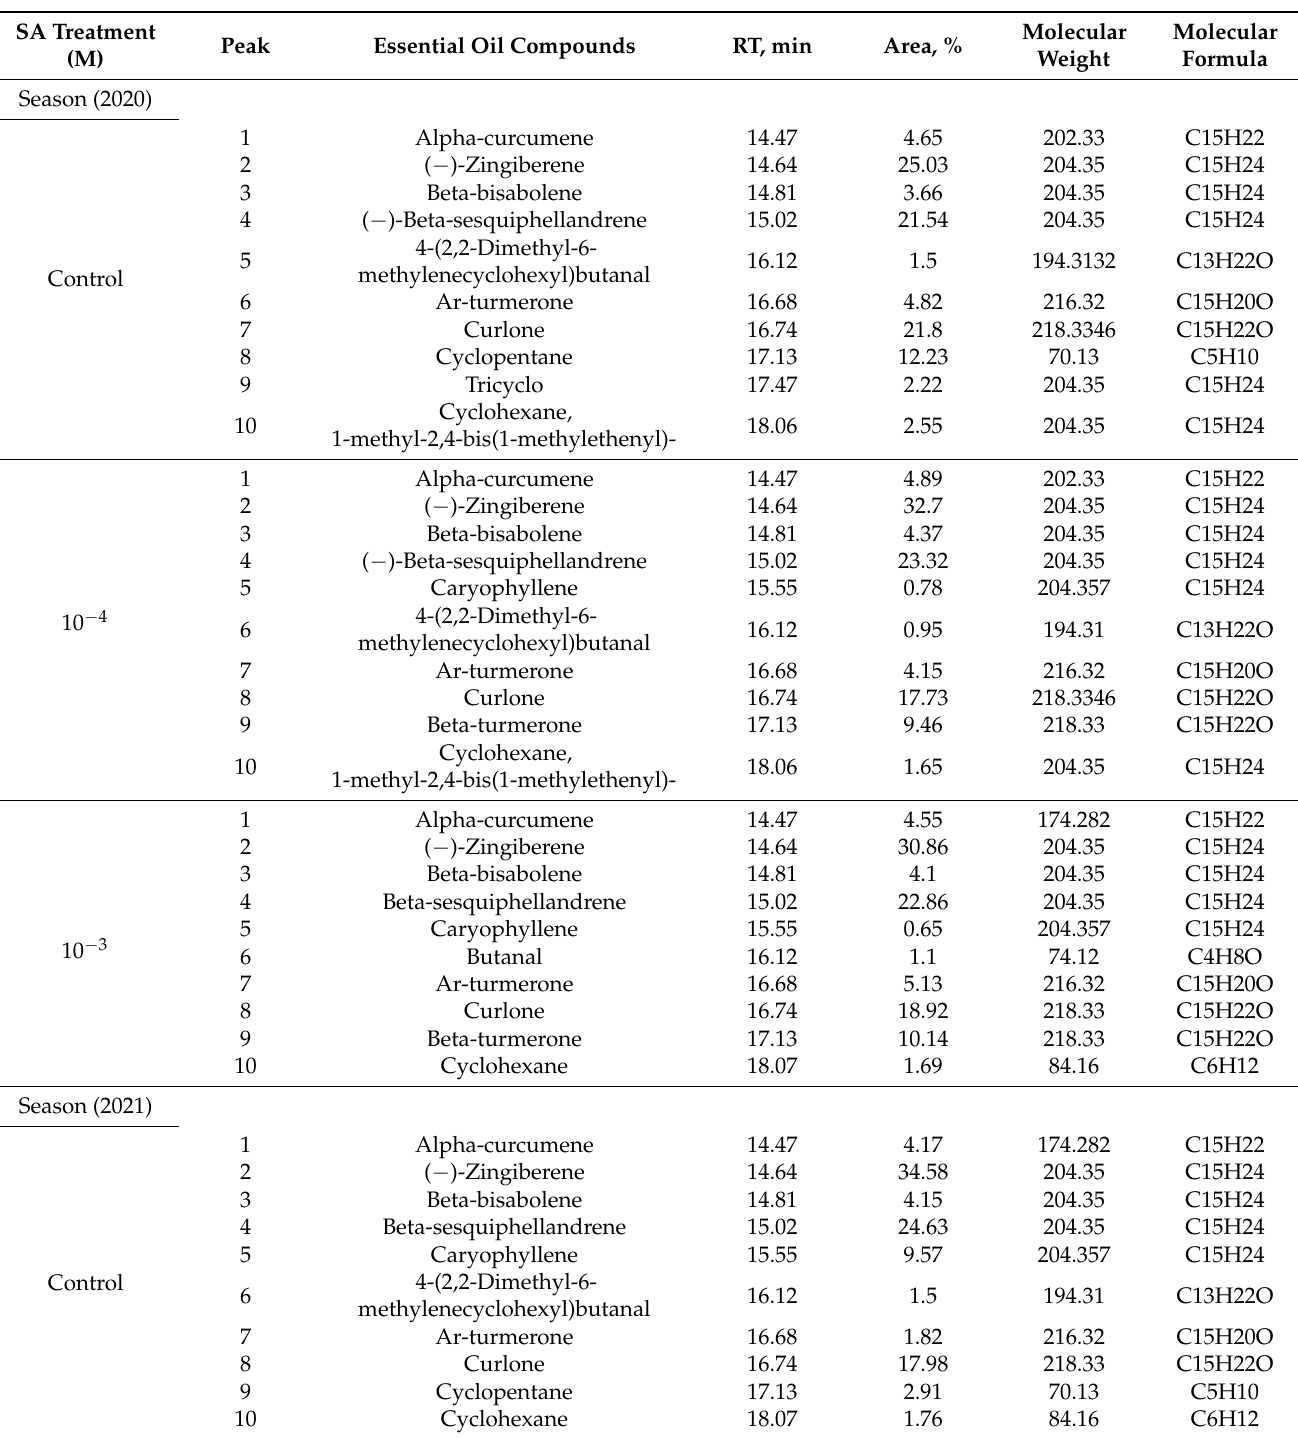
Table 8. Components identified by GC–MS analysis in the C. longa ethanolic rhizome extracts from different treatment groups. Each area (%) was calculated from the measurements obtained from the ethanolic extracts of 3